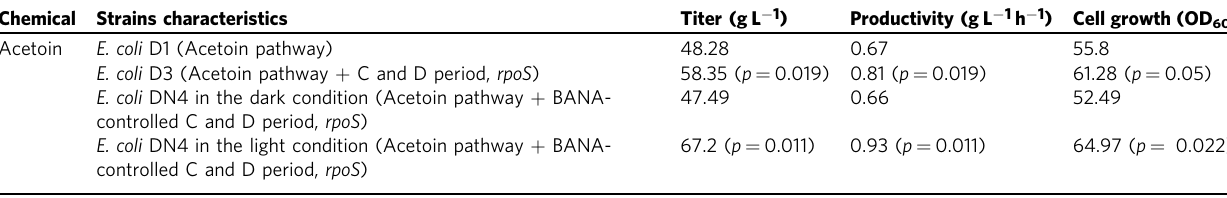
Table 1 Differences in wild type and morphology engineered E. coli on production of acetoin in 5 L fermenter. Chemical Strains